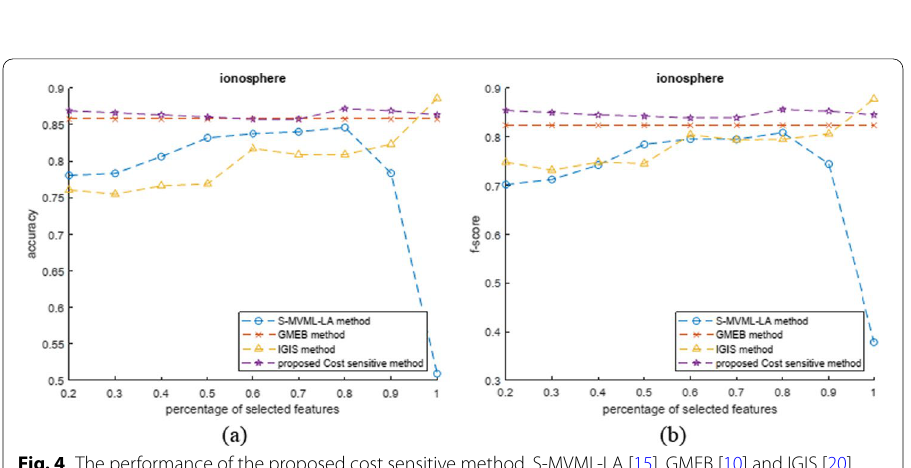
Fig. 4 The performance of the proposed cost sensitive method, S-MVML-LA [15], GMEB [10] and IGIS [20] versus the changes in percentage of selected features numbers on the Ionosphere dataset. a Accuracy, b